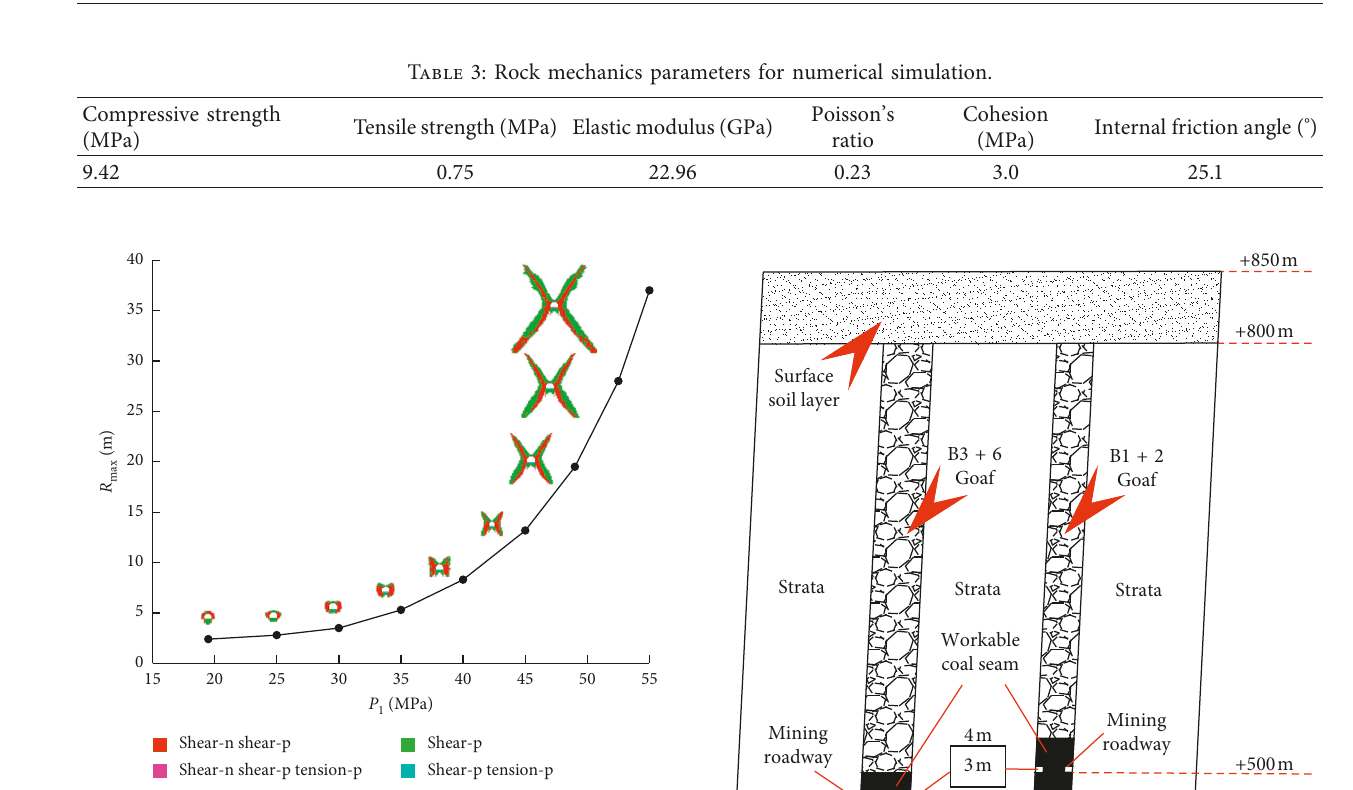
Figure 11: Plastic zone change curve in the 13230 haulage roadway during work face mining.